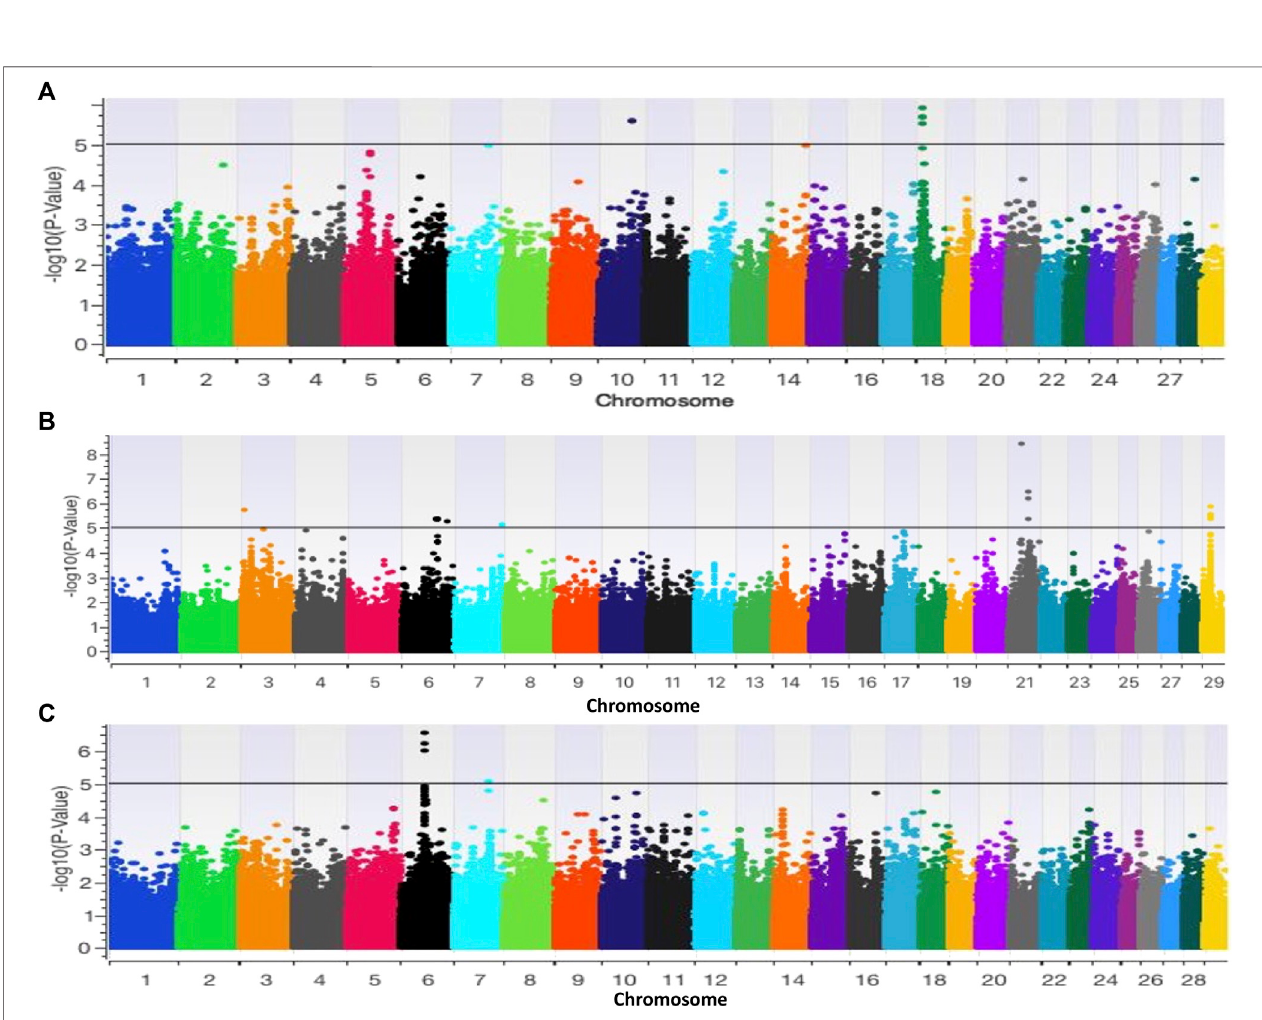
Frontiers in Genetics | www.frontiersin.org June 2022 | Volume 13 | Article 832702